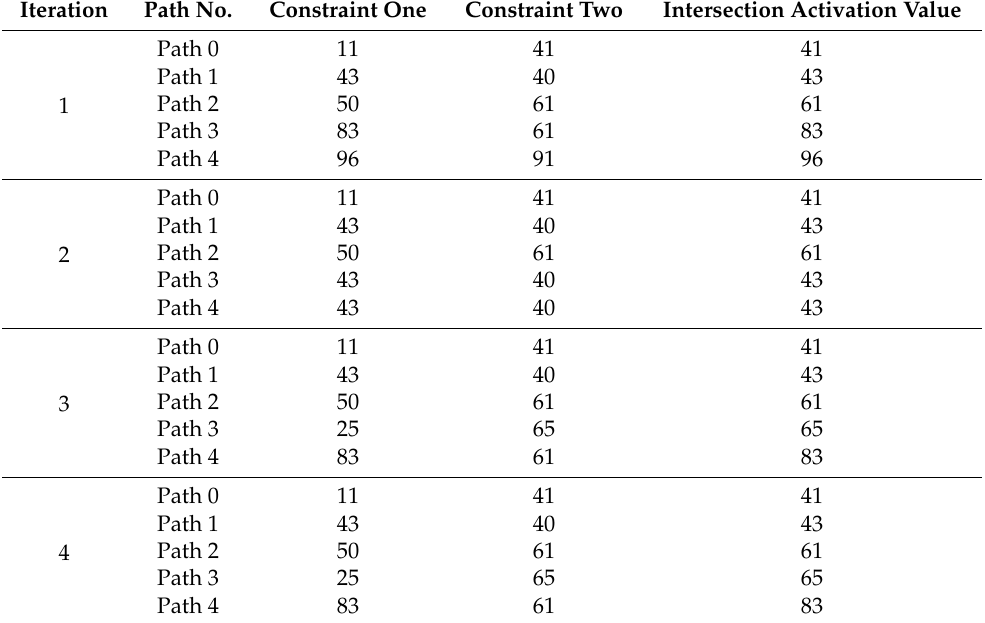
Table 3. Constraints of available paths. Iteration Path